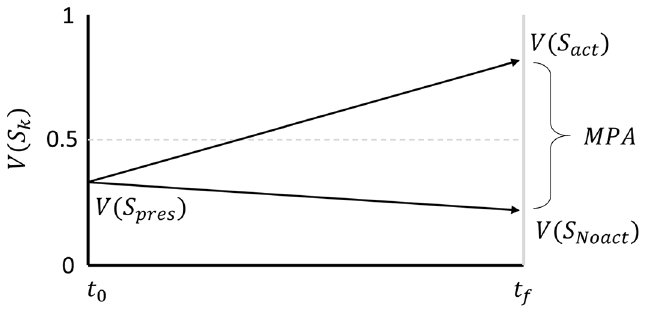
Note. The ensuing motivation for political action (MPA) is also reported. t the